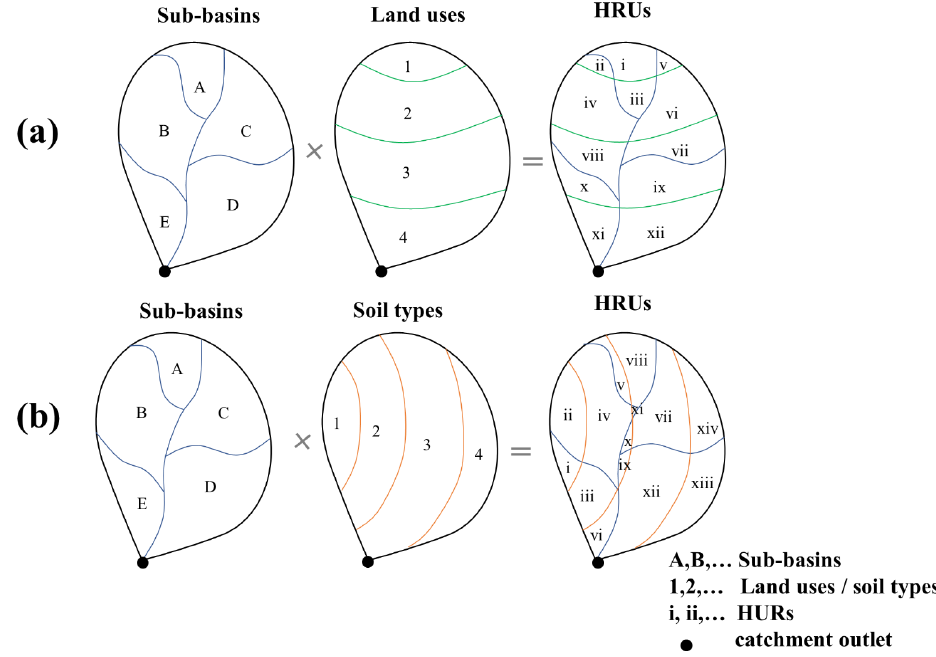
Figure 6. Example of HRU discretization schemes by combining (a) sub-basins and land uses and by combining (b) sub-basins and soil